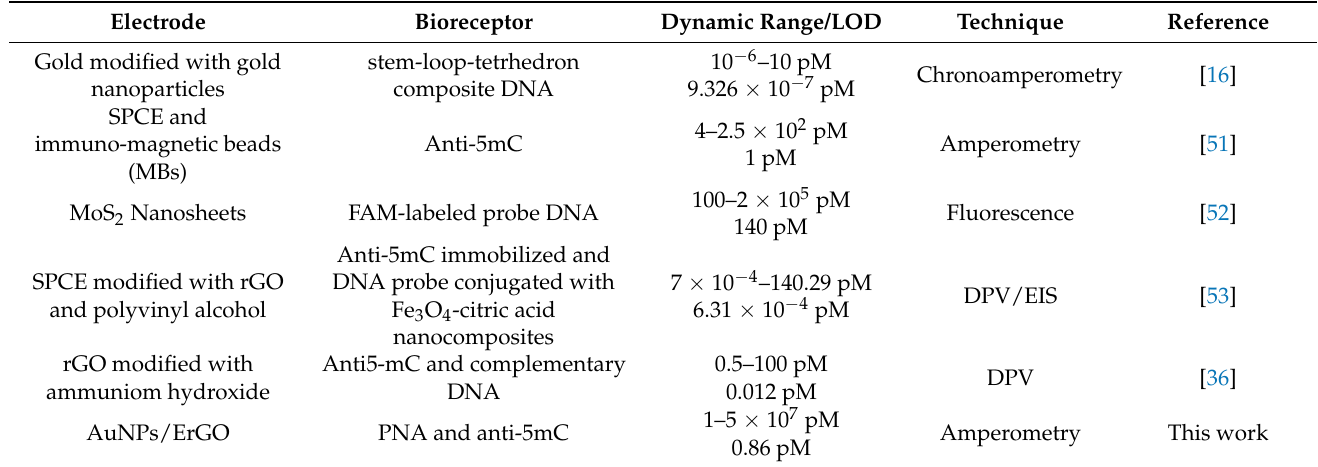
Table 1. A comparison with other biosensing assays to detect methylated